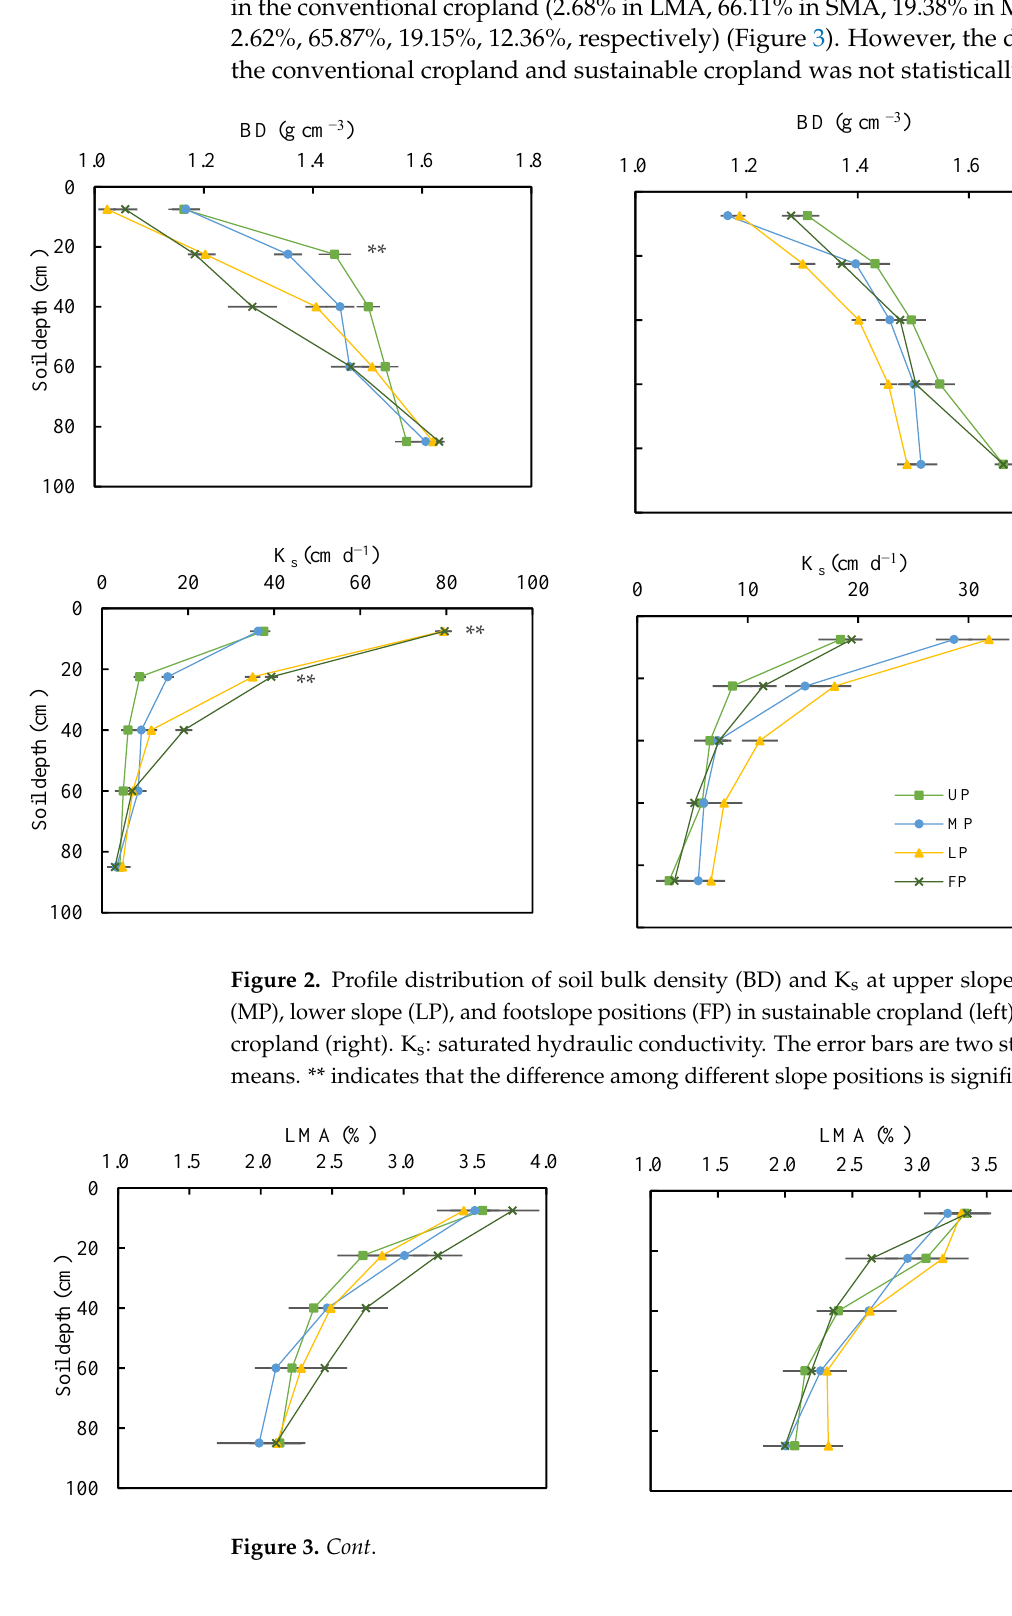
(3) where D i , BD i , OC i , N i, and P i represent the thickness (cm), bulk density (g cm − 3 ), and con- tents of OC (g kg − 1 ), N (g kg − 1 ), and P (g kg − 1 ), respectively, of the i th layer of soil. 2.4. Statistical Analysis Two-way analysis of variance and correlation analyses were conducted using SPSS 13.0 software. Two-way analysis of variance was used to test the slope position and soil depth main effects and interaction effects on soil BD, K s , aggregates, OC, N, and P ( p < 0.05). Correlation analysis was used to evaluate the relationships among the soil variables. Testing of significant differences was performed using the Duncan s test. 3. Results 3.1. Effect of Slope Position and Cropland Management on Bulk Density and Saturated Hydraulic Conductivity The effects of slope position on soil bulk density and K s differed with cropland man- agements (Figure 2). In both conventional and sustainable croplands, soil bulk density decreased but K s increased from the upper slope to the lower slope position. However, in sustainable cropland, soil bulk density was lowest and K s was highest at the footslope